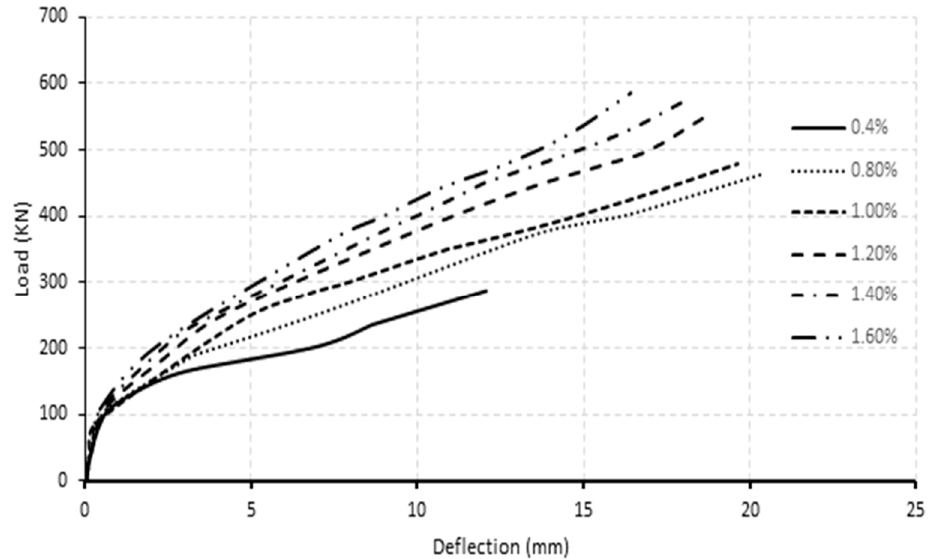
Figure 16. Load–deflection curve for variable longitudinal reinforcement ratio for normal concrete strength beam specimens (80 MPa).